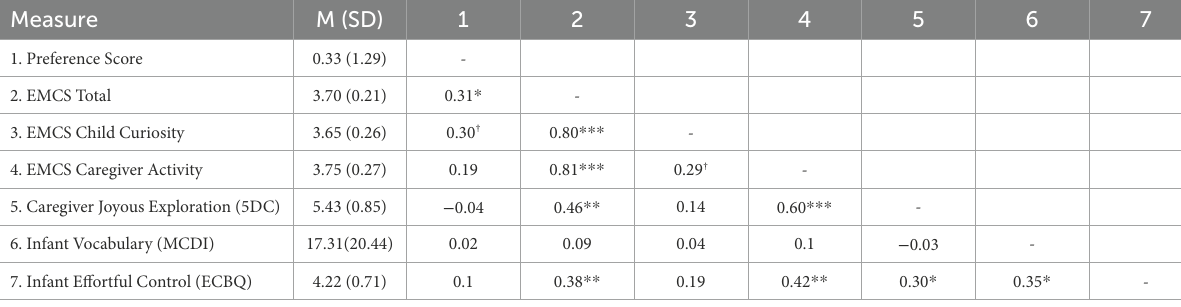
TABLE 1 Descriptive statistics and correlations among the main variables.